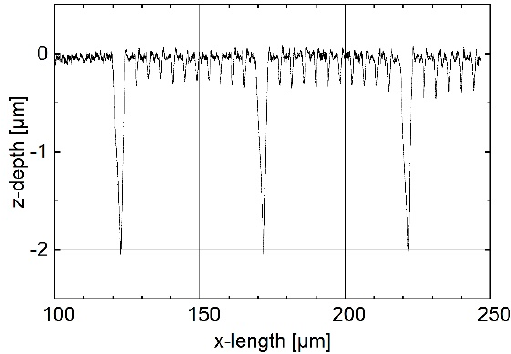
Figure 22. Measured profile section in the area of the grooves with a width between 1.0 µm and 1.2 µm on the probing tip-testing standard.